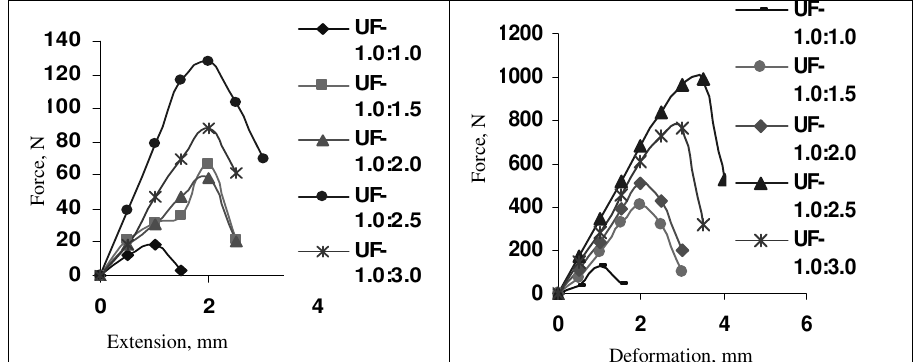
Figure 3. Tensile strength of UF Resin Figure 4. Compressive strength of UF Resin